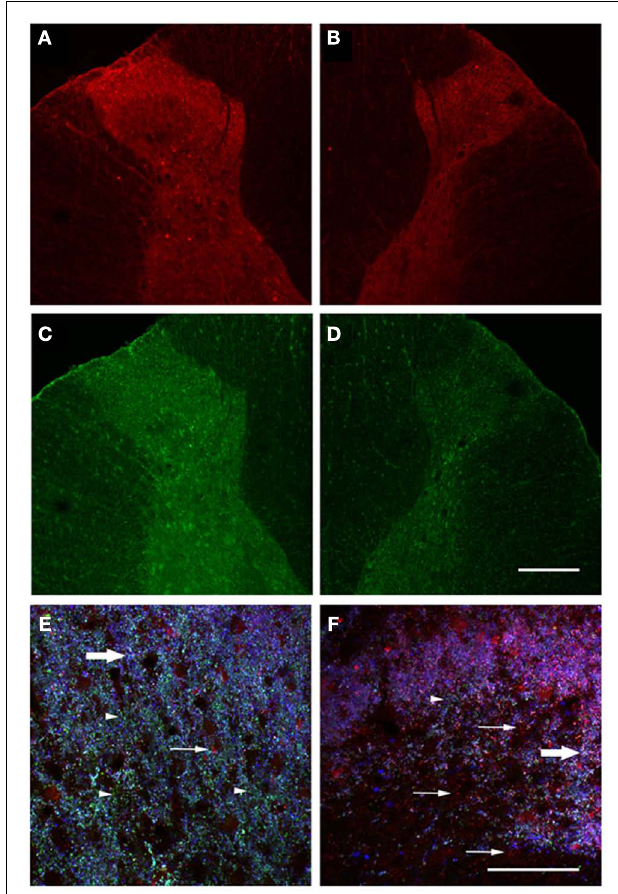
FIGURE 2 | Decreased immunoreactivity for inhibitory signaling components in injured spinal cord gray matter. Spinal cord sections were stained for GABA (A,B) and glycine (C,D) . Uninjured dorsal horns showed robust staining for both neurotransmitters (A,C) , but staining was decreased in injured dorsal horns (B,D) . Spinal cord sections were also triple-stained for GABA,VIAAT, and synaptobrevin. A region within the uninjured dorsal horn was enlarged (E) , showing extensiveVIAAT labeling (arrowheads), few lone GABA puncta (arrows), and numerous triple-labeled white puncta (block arrows). Enlargement of injured dorsal horn (F) revealed substantially decreasedVIAAT, abundant free GABA, and few triple-labeled puncta. Scale bars = 200 μ m (D) ; 50 μ m (F)